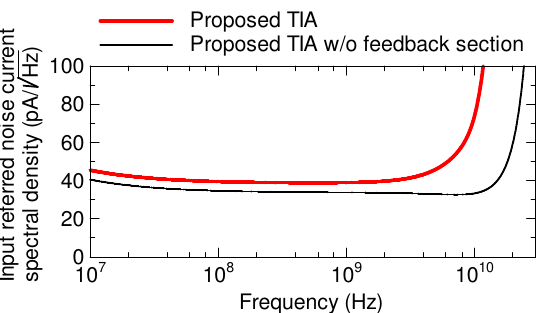
Figure 11. Equivalent input noise current spectral density of the proposed TIA.